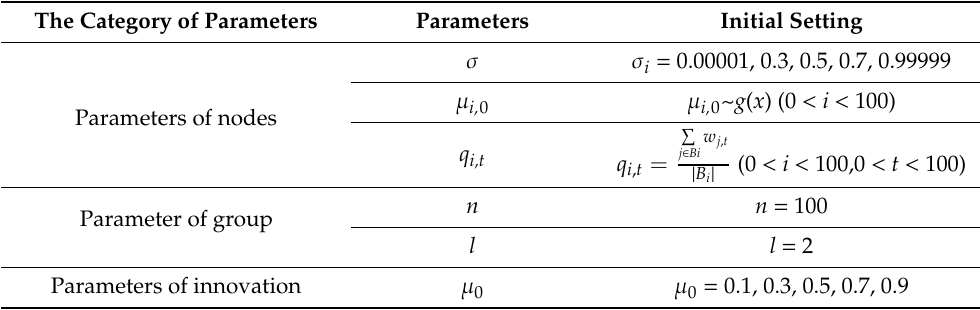
Table 1. Initial